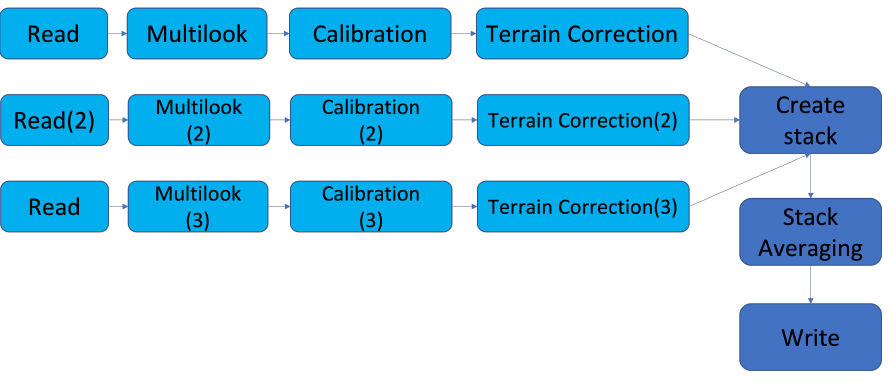
Figure 5. SNAP processing